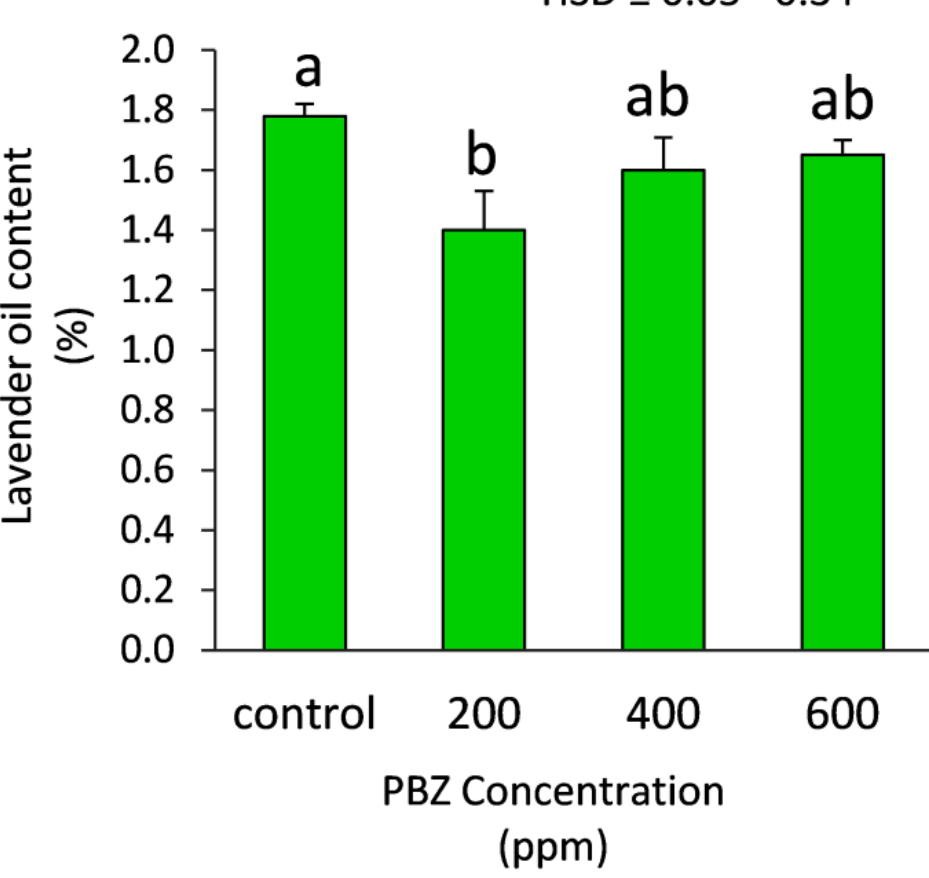
Figure 2. Effect of paclobutrazole (PBZ) on the yield of lavender essential oil (%) in the dried vegetative parts (leaves and stem). Values are the averages of 3 replicates ± SD. Different letters indicate significant differences, according to Tukey’s Studentized Range (HSD) Test ( p < 0.05).